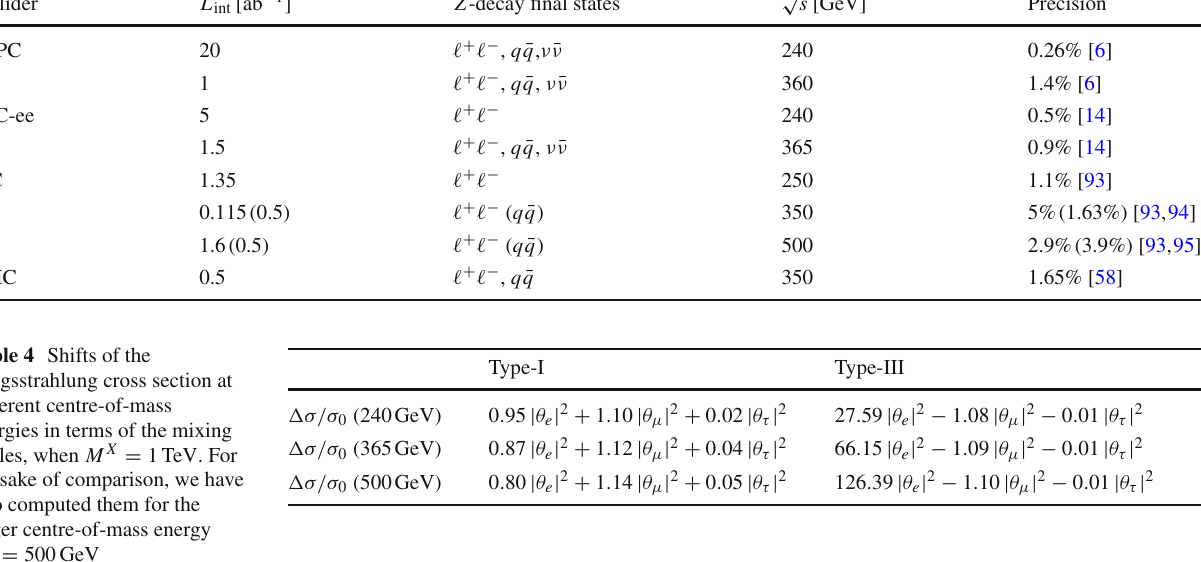
Table 3 Forecast (statistical) precision of measurements of the Hig- gsstrahlung cross section at different proposed next-generation collid- ers. In the third column, the Z -decay final states taken into account in the respective analysis are given; (cid:10) + (cid:10) − always implies both Z → e + e − and Z → μ + μ − . For the results from Ref.[93] a polarisa- tion ( P e − , P e + ) = ( − 80% , + 30% ) is assumed, still, this changes the Collider